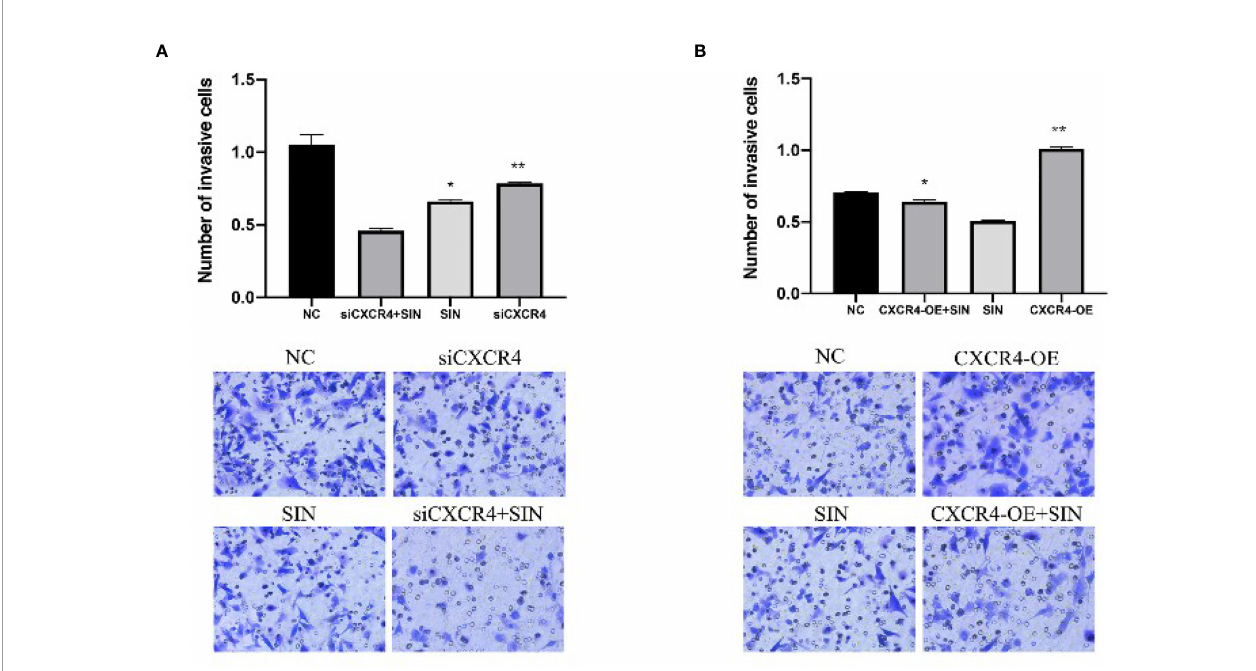
FIGURE 3 | The CXCL12-CXCR4 axis participates in the effect of sinomenine hydrochloride on HCC cell aggression. CXCR4 knockdown and overexpression in SK- Hep1 cells. (A, B) Transwell assay for cell invasion (×200). *P < 0.05, **P <